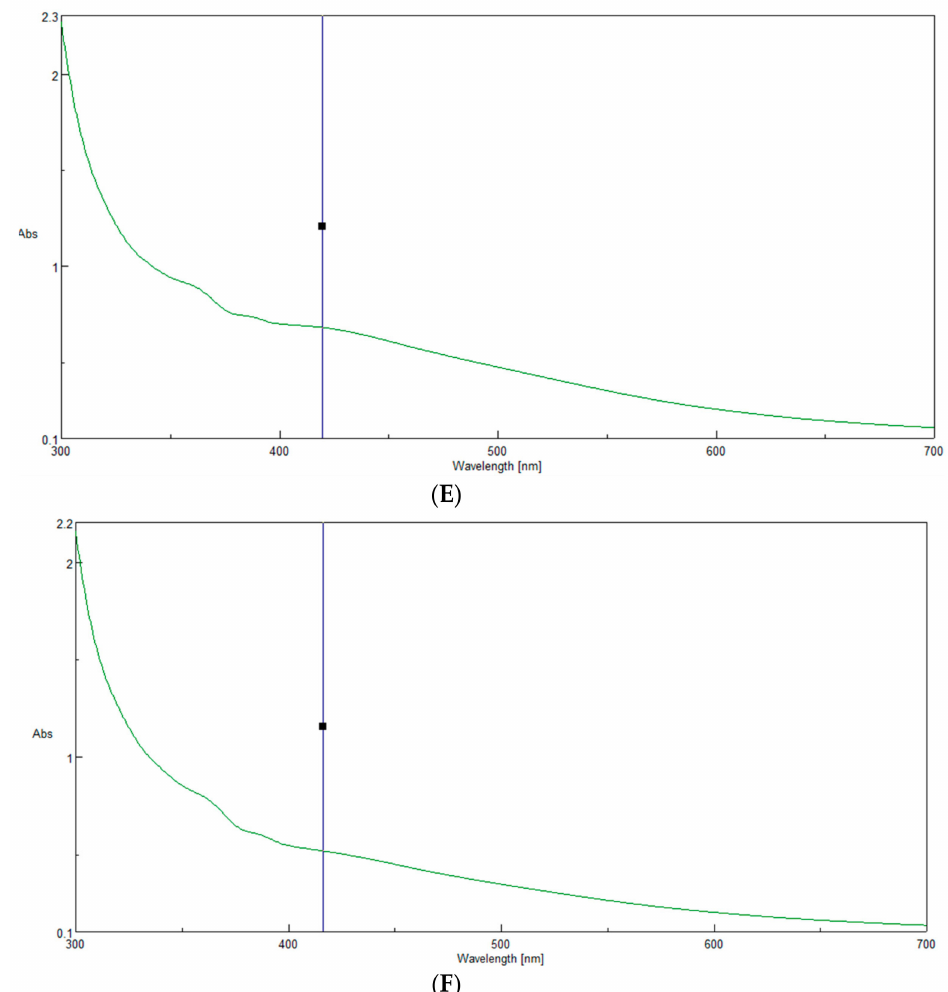
Figure 2. Ultraviolet and visible (UV–Vis) spectra of AgNP solutions produced by ( A ) process A + 1 mM AgNO 3 , ( B ) process A + 2 mM AgNO 3 , ( C ) process B + 1 mM AgNO 3 , ( D ) process B + 2 mM AgNO 3 , ( E ) process C + 1 mM AgNO 3 and ( F ) process C + 2 mM AgNO 3